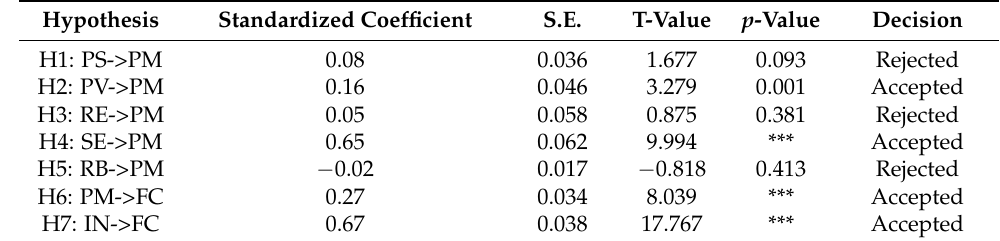
Table 5. Results of hypotheses tests in the Structural Equation Modeling.